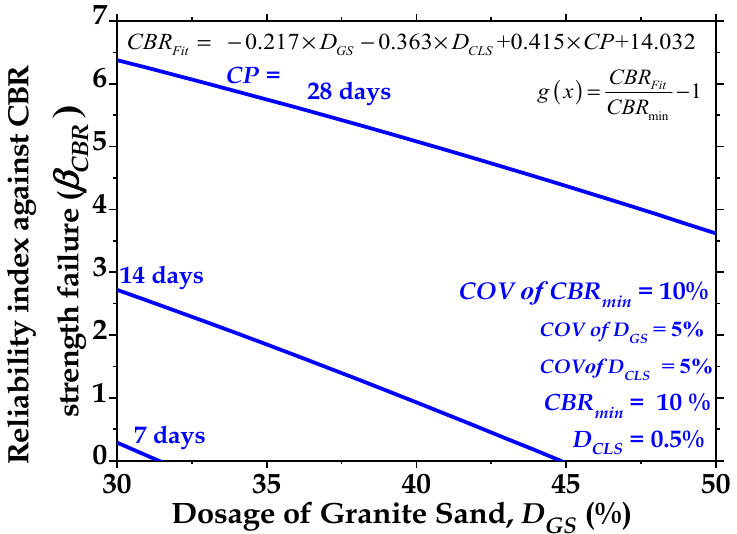
Figure 15. Effect of curing period (CP) on reliability index against CBR strength failure ( β CBR ) with dosages of granite sand (D GS ) for dosage of CLS (D CLS ) = 0.5%.